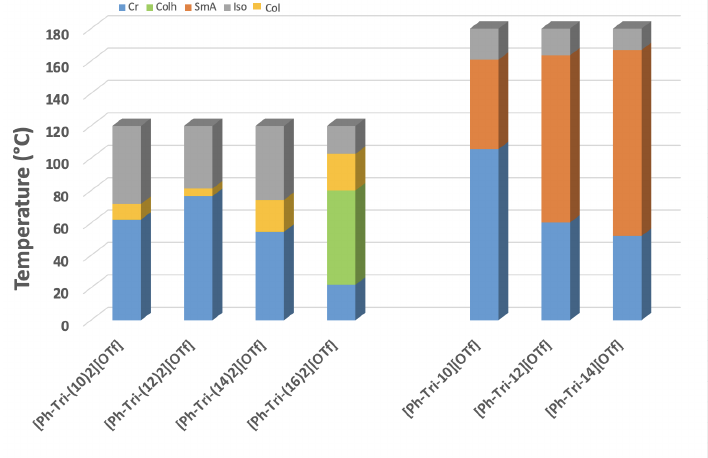
Figure 4. Plot of transition temperatures of LCs reported in this work and in previously reported data [23]. Abbreviations: Iso — isotropic phase; LC — iquid crystalline phase; Col — columnar, Col h , — columnar hexagonal, SmA — smectic A phase, Cr — crystalline solid state. 4. Conclusions A new series of ILCs have been synthesized and their ionic liquid crystalline behav- iour has been investigated by combining DSC and POM analyses. The salts gained a liquid crystalline behaviour when compared to the neutral tria- zoles. Different from what was previously observed for mono alkyloxy phenyl triazolium